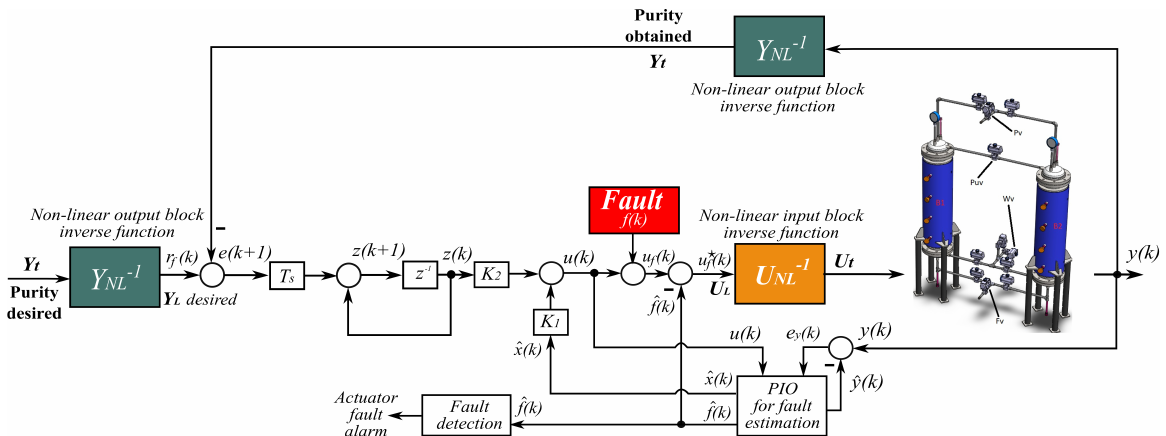
Figure 21. Scenario 2: Active FTC scheme applied to PSA